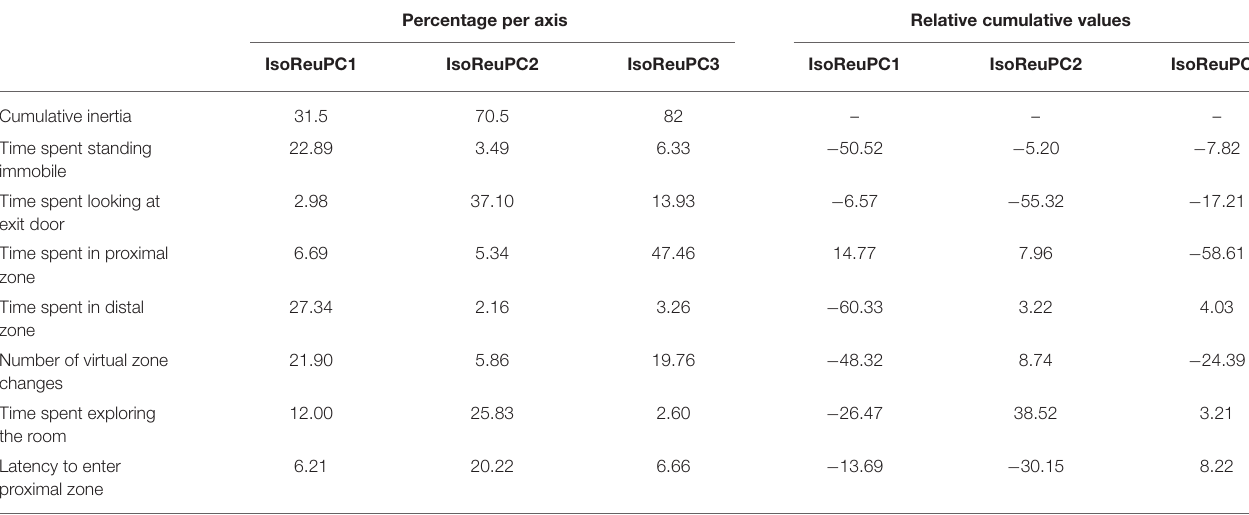
TABLE 3 | Variable loadings of the behavioral parameters used in the Principal Component Analysis in the Isolation/Reunion